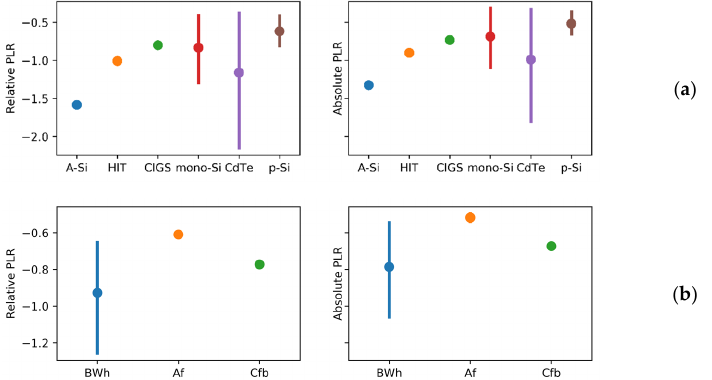
Figure 9. Performance loss rate of the PV systems using STL. ( a ) Grouped by module technologies, ( b ) grouped by climate. Left: relative values, right: absolute values.